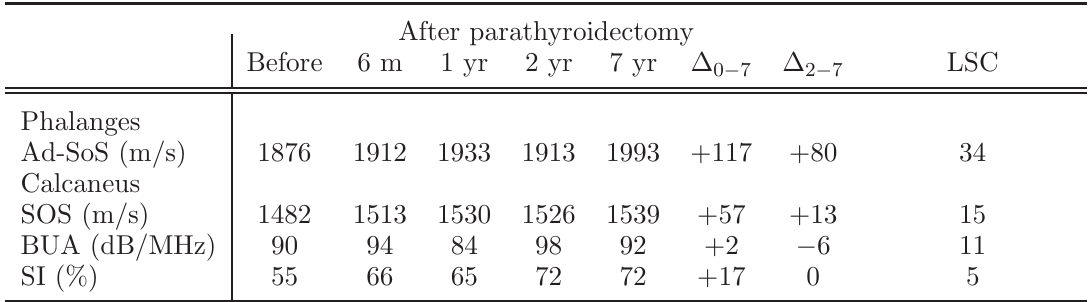
Table 1 Results of QUS measurements in patient with primary hyperparathyroidism before and after parathyroid adenoma surgery. Presentation of the differences between values according to least significant change .